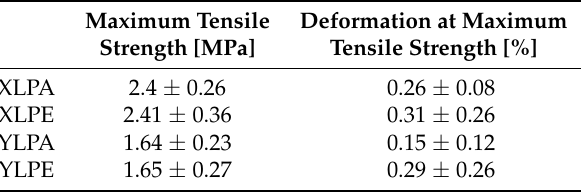
Table 5. Maximum mechanical performance of printed